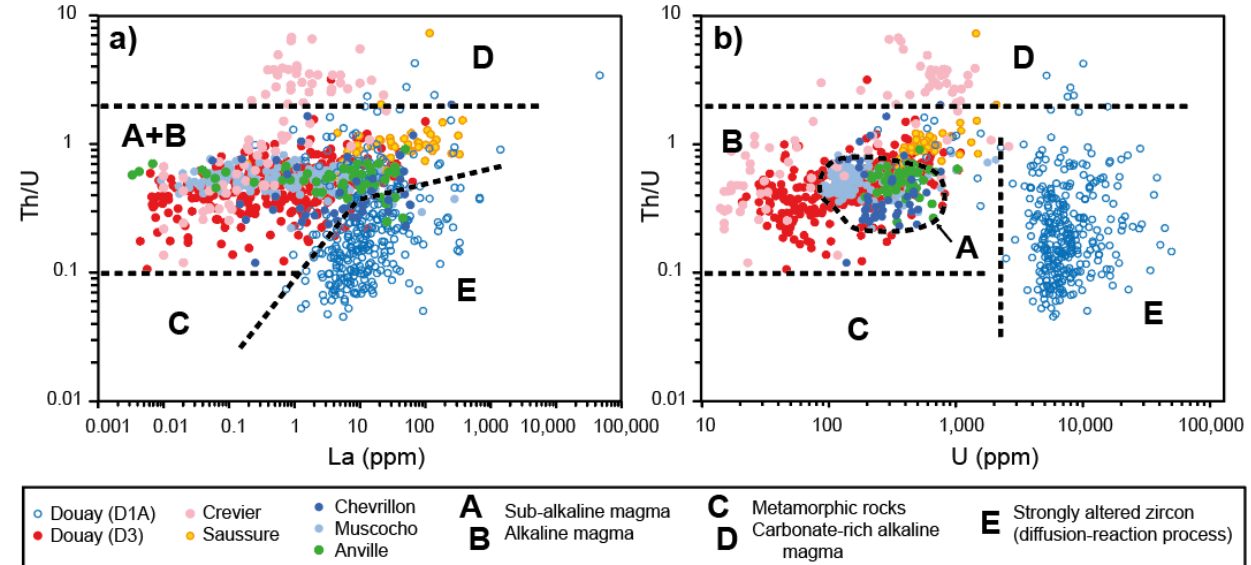
Figure 13. Discrimination diagrams for zircon; ( a ) Th/U vs. La, and ( b ) Th/U vs. U binary diagrams. A total of n = 322 (sample D1A) and n = 292 (sample D3) analyses are presented for the Douay intrusion. For the Crevier (n = 103), Saussure (n = 46), Chevrillon (n = 45), Muscocho (n = 236), and Anville (n = 52) plutons, data are compiled from the literature [13,14,56]. The location of field C (metamorphic environment) is deduced from the literatures [77,79].